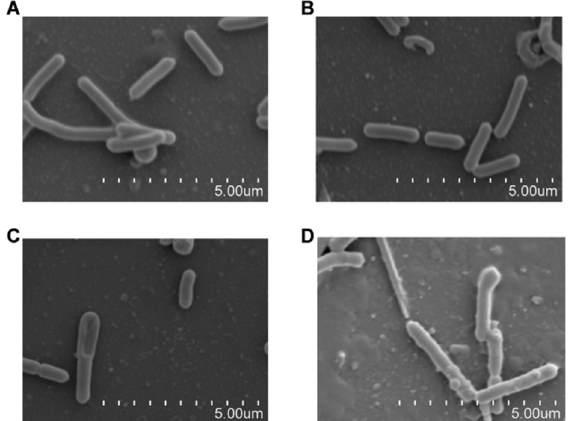
Figure 9. LCA combined with Genta induced L. monocytogenes membrane injury as observed by scanning electron microscopy. ( A ) Normal morphology of L. monocytogenes . ( B ) Surface image of L. monocytogenes after treatment with 8 µ g/mL LCA. ( C ) Surface image of L. monocytogenes after treatment with 0.125 µ g/mL Genta. ( D ) Rupture of the membrane of L. monocytogenes following treatment with 8 µ g/mL LCA and 0.125 µ g/mL Genta.